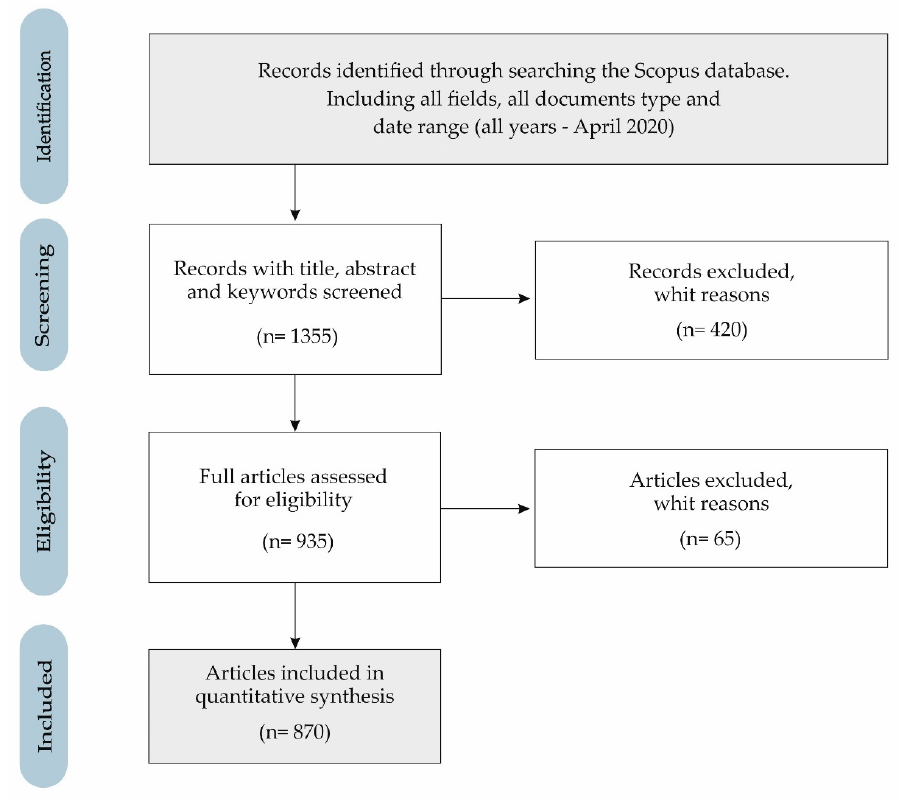
Figure 2. Flow diagram of the sample selection (PRISMA).